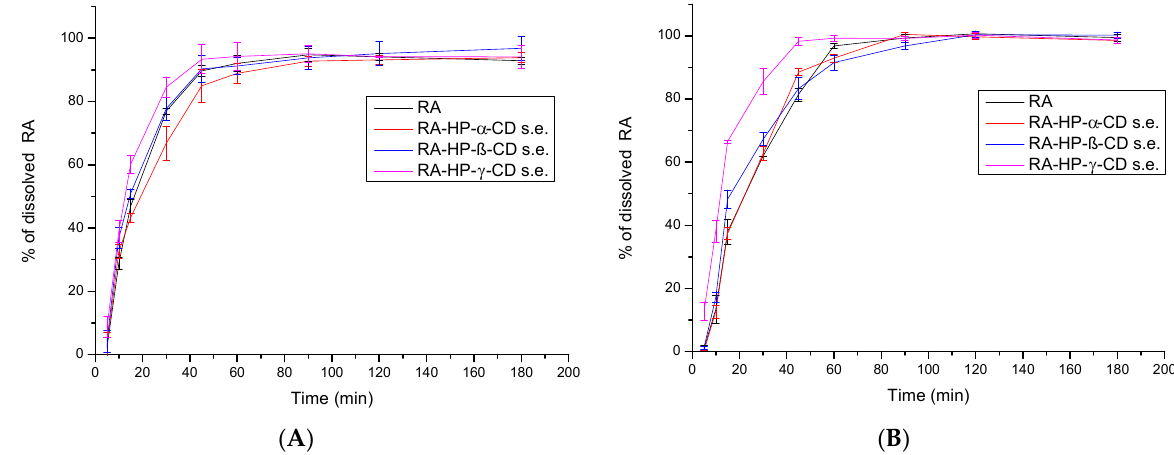
Figure 7. Apparent solubility of RA and RA in binary systems prepared by the solvent evaporation method: RA–HP-α-CD s.e., RA–HP-β-CD s.e., RA–HP-γ-CD s.e. in a pH of 4.5 ( A ) and in a pH of 5.8 ( B ).